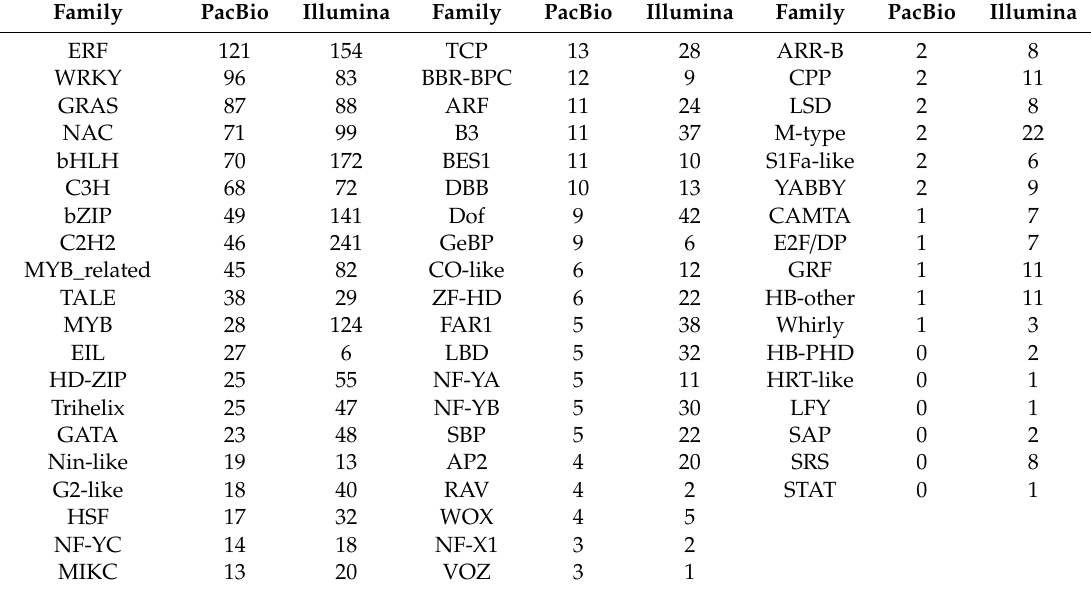
Table 1. Statistics for the transcriptional factor (TF) family predicted by Illumina and PacBio in M. pasquieri . Family PacBio